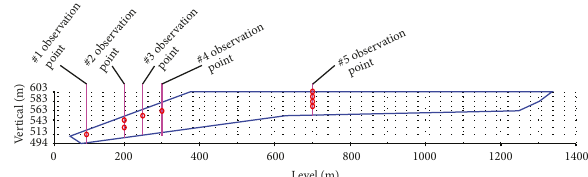
Figure 11: Location of the leachate level observation well.